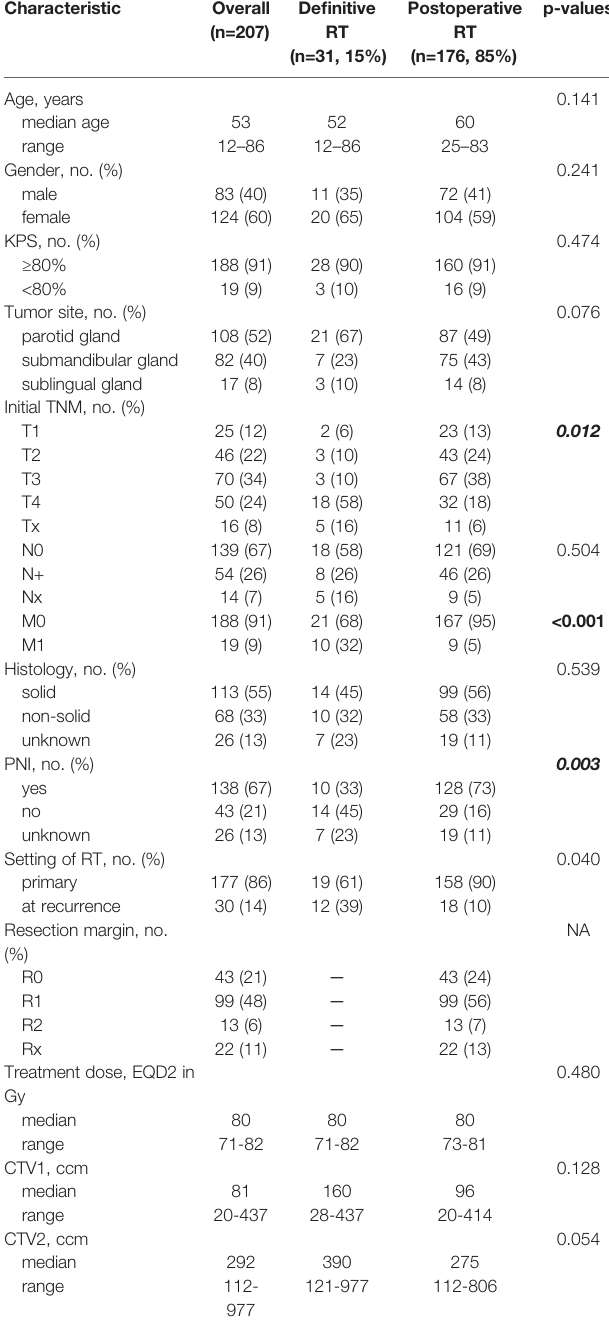
KPS, Karnofsky Performance Score; PNI, perineural invasion; EQD2, equivalent dose to 2 Gyfractions;CTV1,clinicaltargetvolume1includingthetumor/tumorbed(Boostvolume); CTV2, clinical target volume including CTV1 and neck lymph